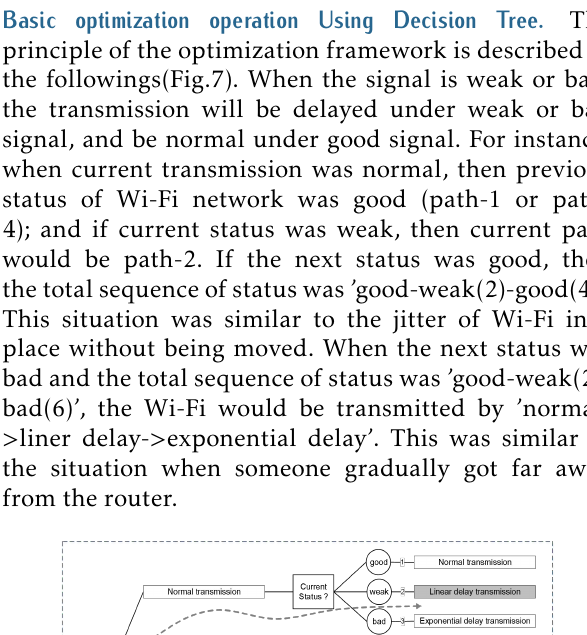
Fig. 5. The framework of the optimization mechanism